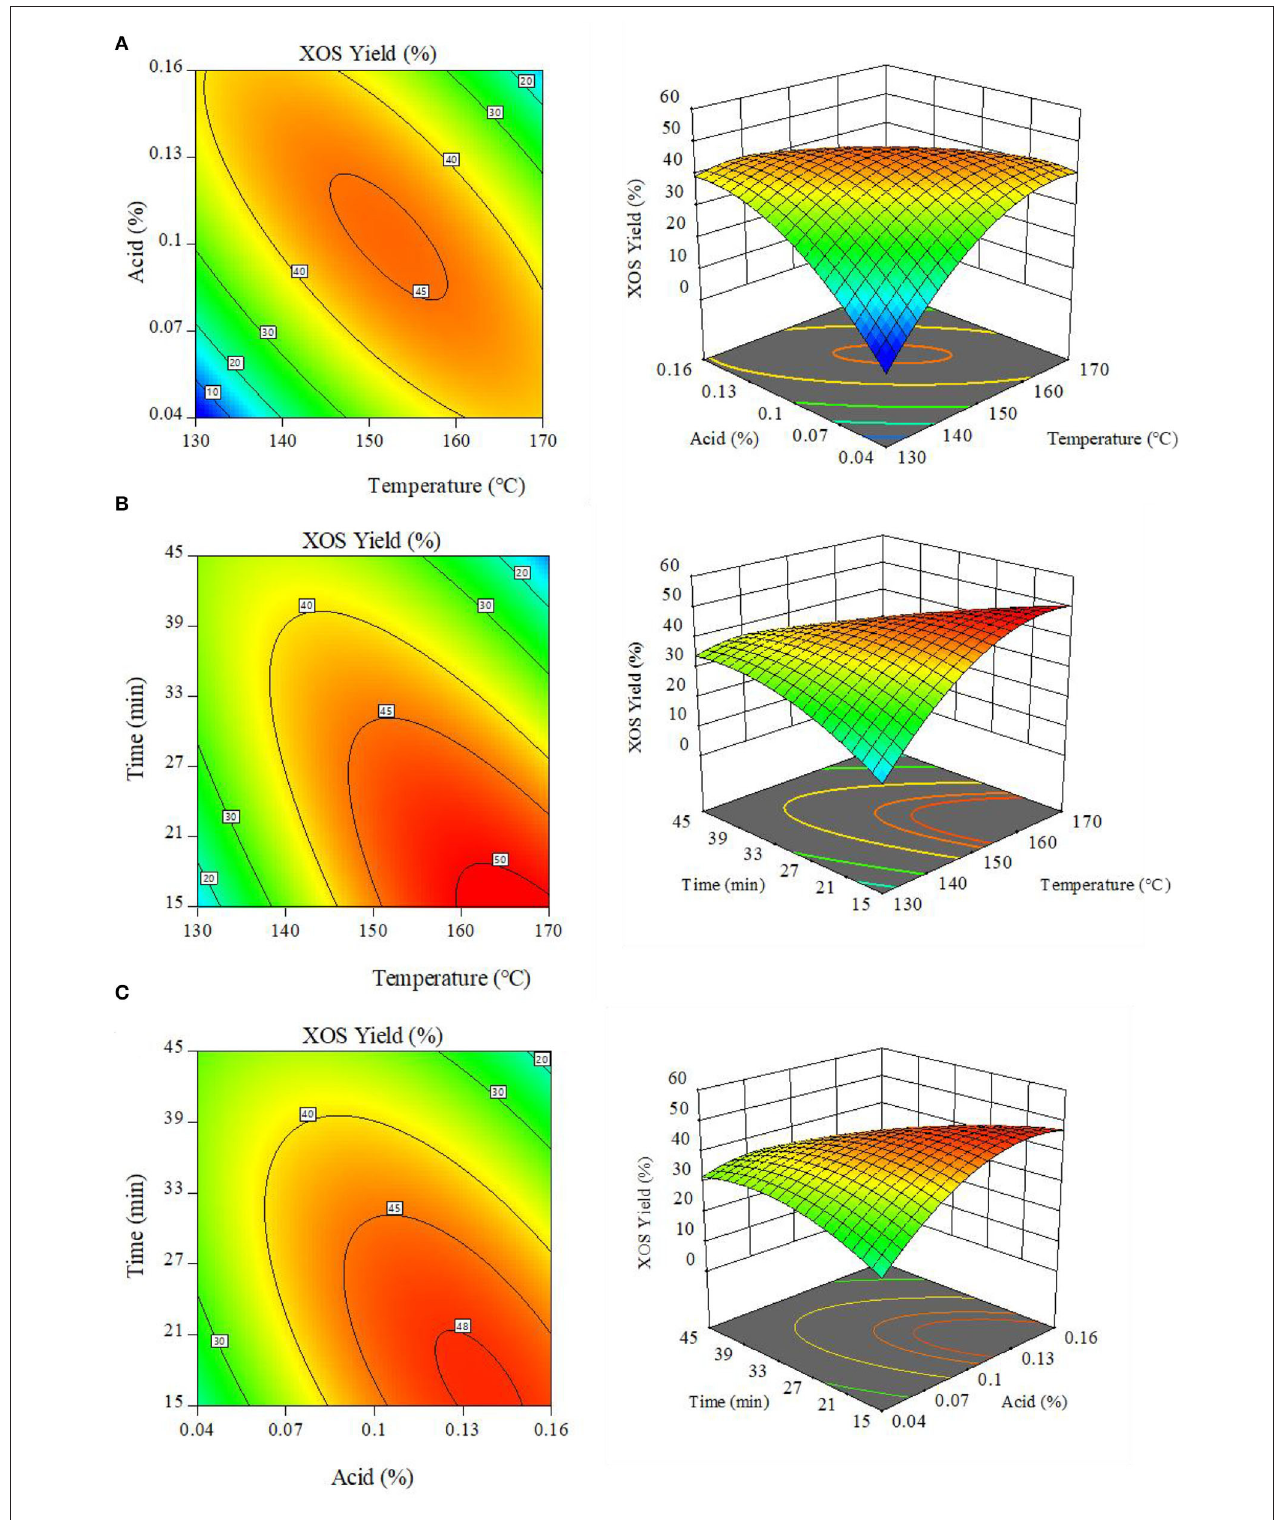
FIGURE 3 | Response surface plots demonstrating the interactive effects of (A) reaction temperature and MA content. (B) reaction temperature and holding time; and (C) MA content and holding time on XOS production. XOS: xylooligosaccharides = X2 + X3 + X4 + X5 + X6.